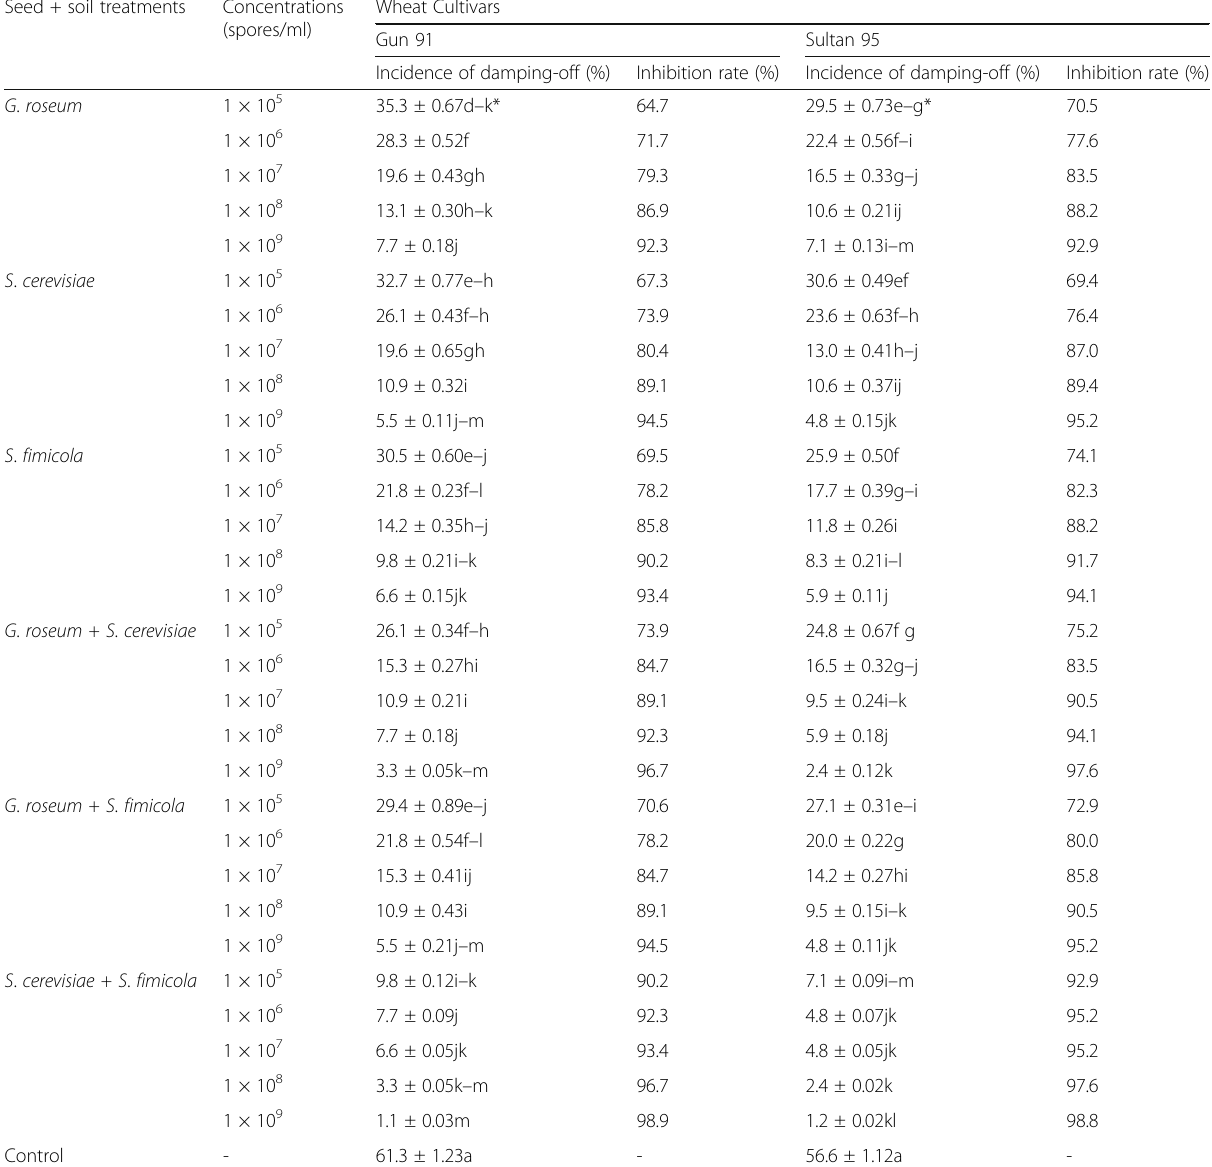
Table 5 Effect of different concentrations of the seed + soil treatments on damping-off caused by F . graminearum in wheat cultivars Seed + soil treatments Concentrations